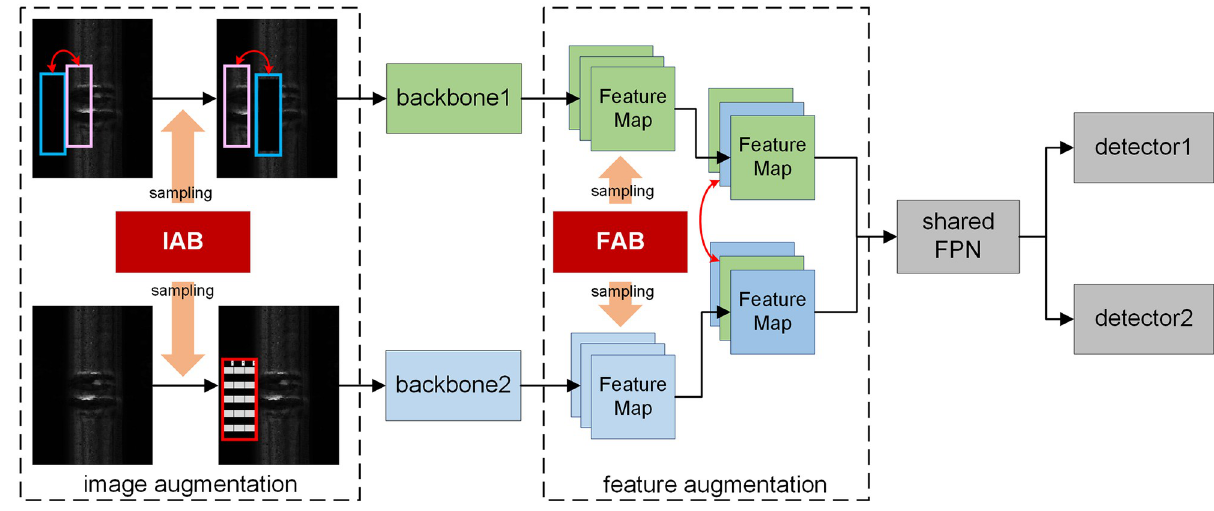
Fig 2. Structure of the proposed MBDA framework. The input image is a detection sample of YOLO v5.